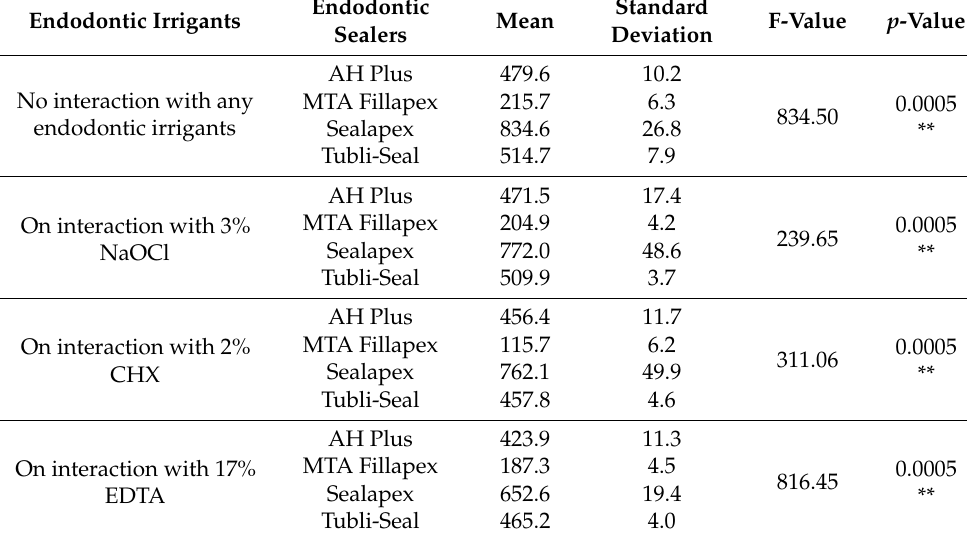
Table 3. Mean and standard deviation of the setting time of different endodontic base sealers and on interaction with commonly used endodontic irrigants in minutes (min). One way ANOVA test showed a statistically significant difference in all groups ( p < 0.05).